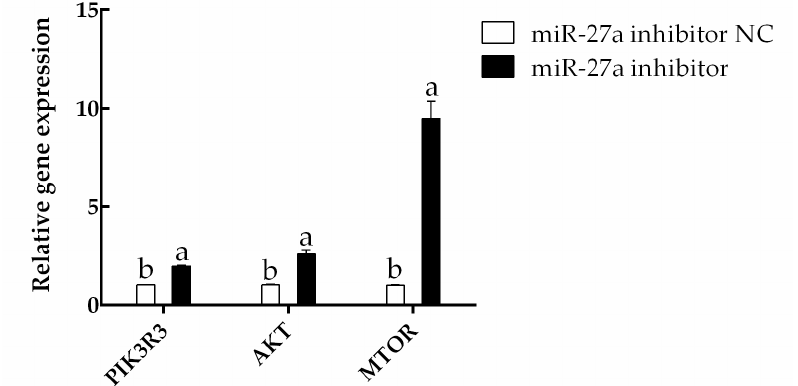
Figure 10. Transfection with an miR-27a inhibitor increases the expression of PIK3R3 , AKT , and MTOR . HFSCs were transfected with the noted siRNAs, and gene expression was determined by RT-qPCR. The different small letters (a, b) in the same graph indicate that the difference between groups is statistically significant ( p < 0.05).